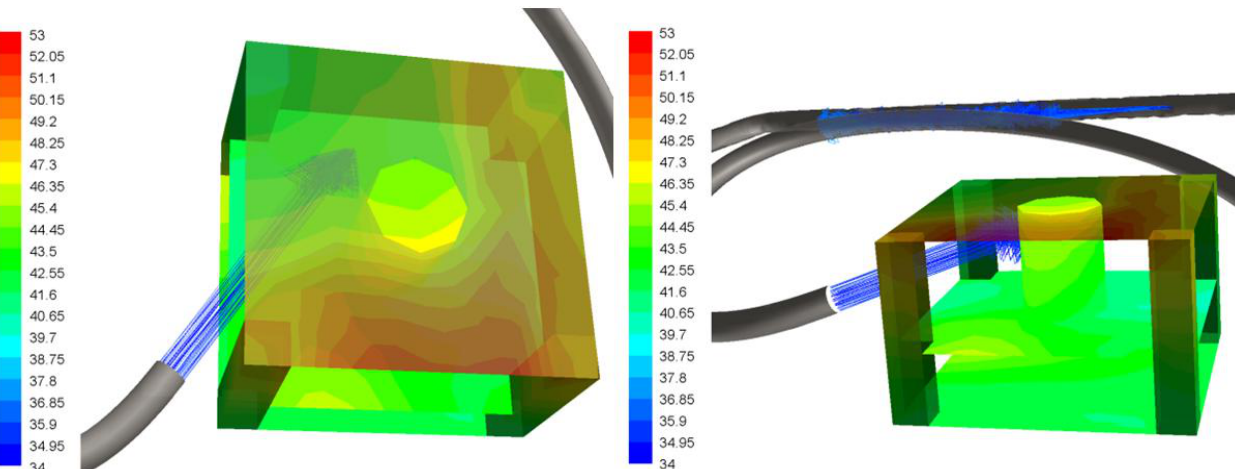
Figure 8. Temperature maps of the camera